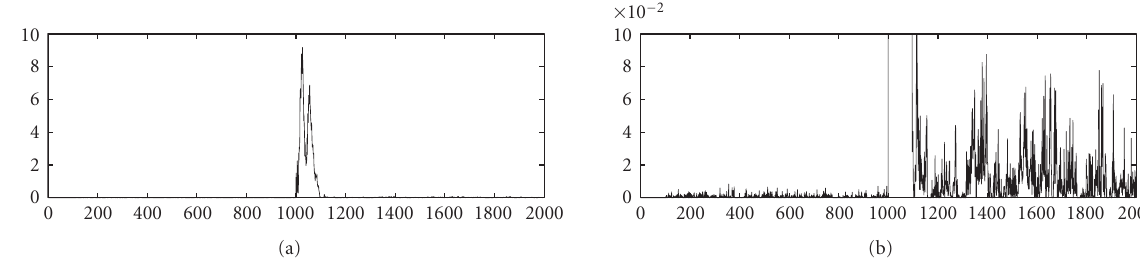
Figure 1: Fault detection residual. The same residual is plotted twice at di ff erent scales. The time unit is the minute.